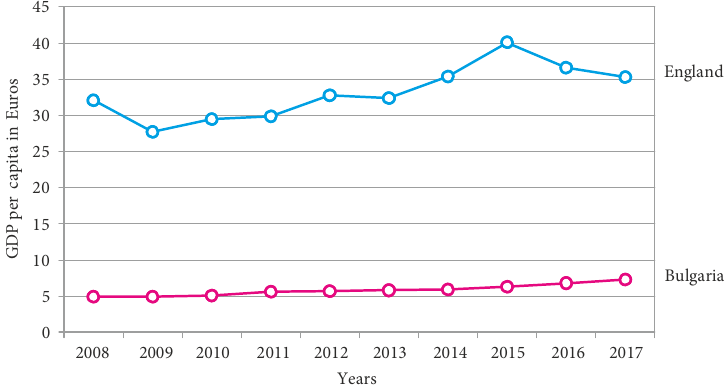
Figure 1. GDP per capita in England and Bulgaria (source: Eurostat, 2019) Table 1. Matrix of quantitative assessment of national economic development (source: compiled by authors) Aspect of